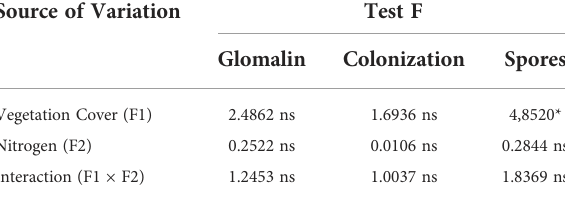
TABLE 1 Analysis of variance of easily extracted glomalin contents, mycorrhizal colonization rate and number of soil spores. Source of Variation